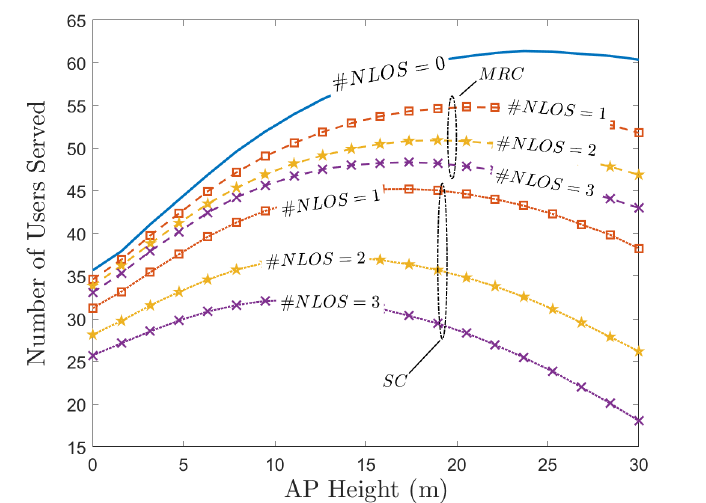
Figure 15. Average users served M s within square area 200m × 200 m vs. UCA height h , and solid lines are the no NLOS ( L = 1), while dashed lines with a marker are the with NLOS for L = 2,3,4, with maximal ratio combining (MRC) and selection combining (SC) receivers for N c = 500, λ = 10 − 2 m − 2 , 2 b = 2.6, SIR threshold [ T ] dB = 0, R max = 400 m, the normalized amplitude | β (cid:96) | = 1 for every path (cid:96)